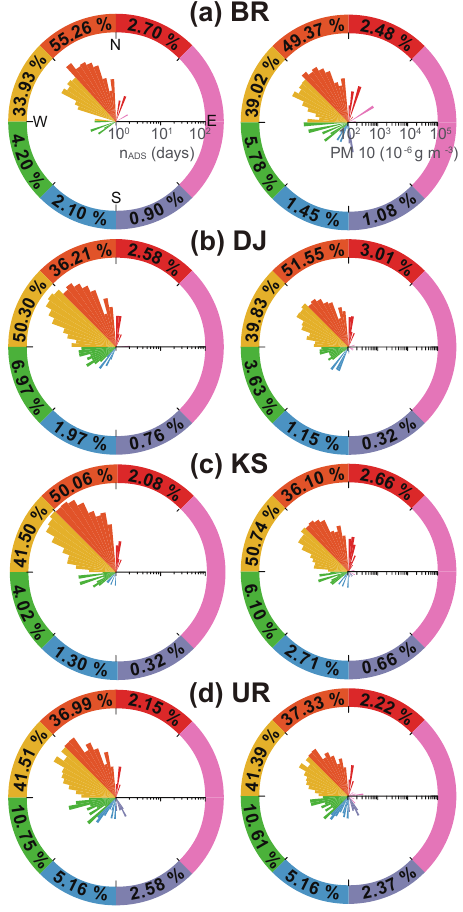
Figure 7. Spatial distribution of ADSs on a rose diagram for (a) BR, (b) DJ, (c) KS, (d) UR. The left panel shows an angular distribution of the number of days each year with ADS events ( n ADS ) . The right panel shows an angular distribution of PM 10 dust air